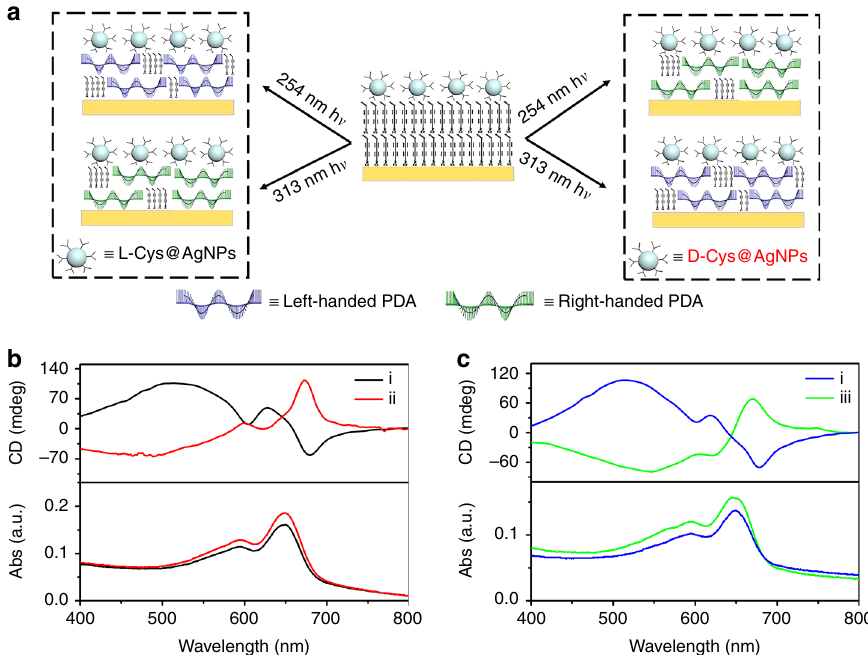
Fig. 2 Handedness of PDA depends on both chiral con fi guration of ligands on plasmonic nanoparticles (L- vs. D-) and wavelength of UV irradiation (254 nm vs. 313 nm). a Handedness of PDA obtained with all four possible combinations. Left-handed PDA is obtained using 254 nm irradiation assisted with L-Cys@NPs or 313 nm irradiation assisted with D-Cys@NPs. Right-handed PDA is obtained using 254 nm irradiation assisted with D-Cys@NPs or 313 nm irradiation assisted with L-Cys@NPs. b CD spectra showing that chirality of PDA is reversed using (i) L - and (ii) D -Cys@AgNPs upon irradiated with 254 nm unpolarized light. c CD spectra showing that chirality of PDA is reversed using (iii) 313 nm irradiation instead of (i) 254 nm unpolarized light in the presence of